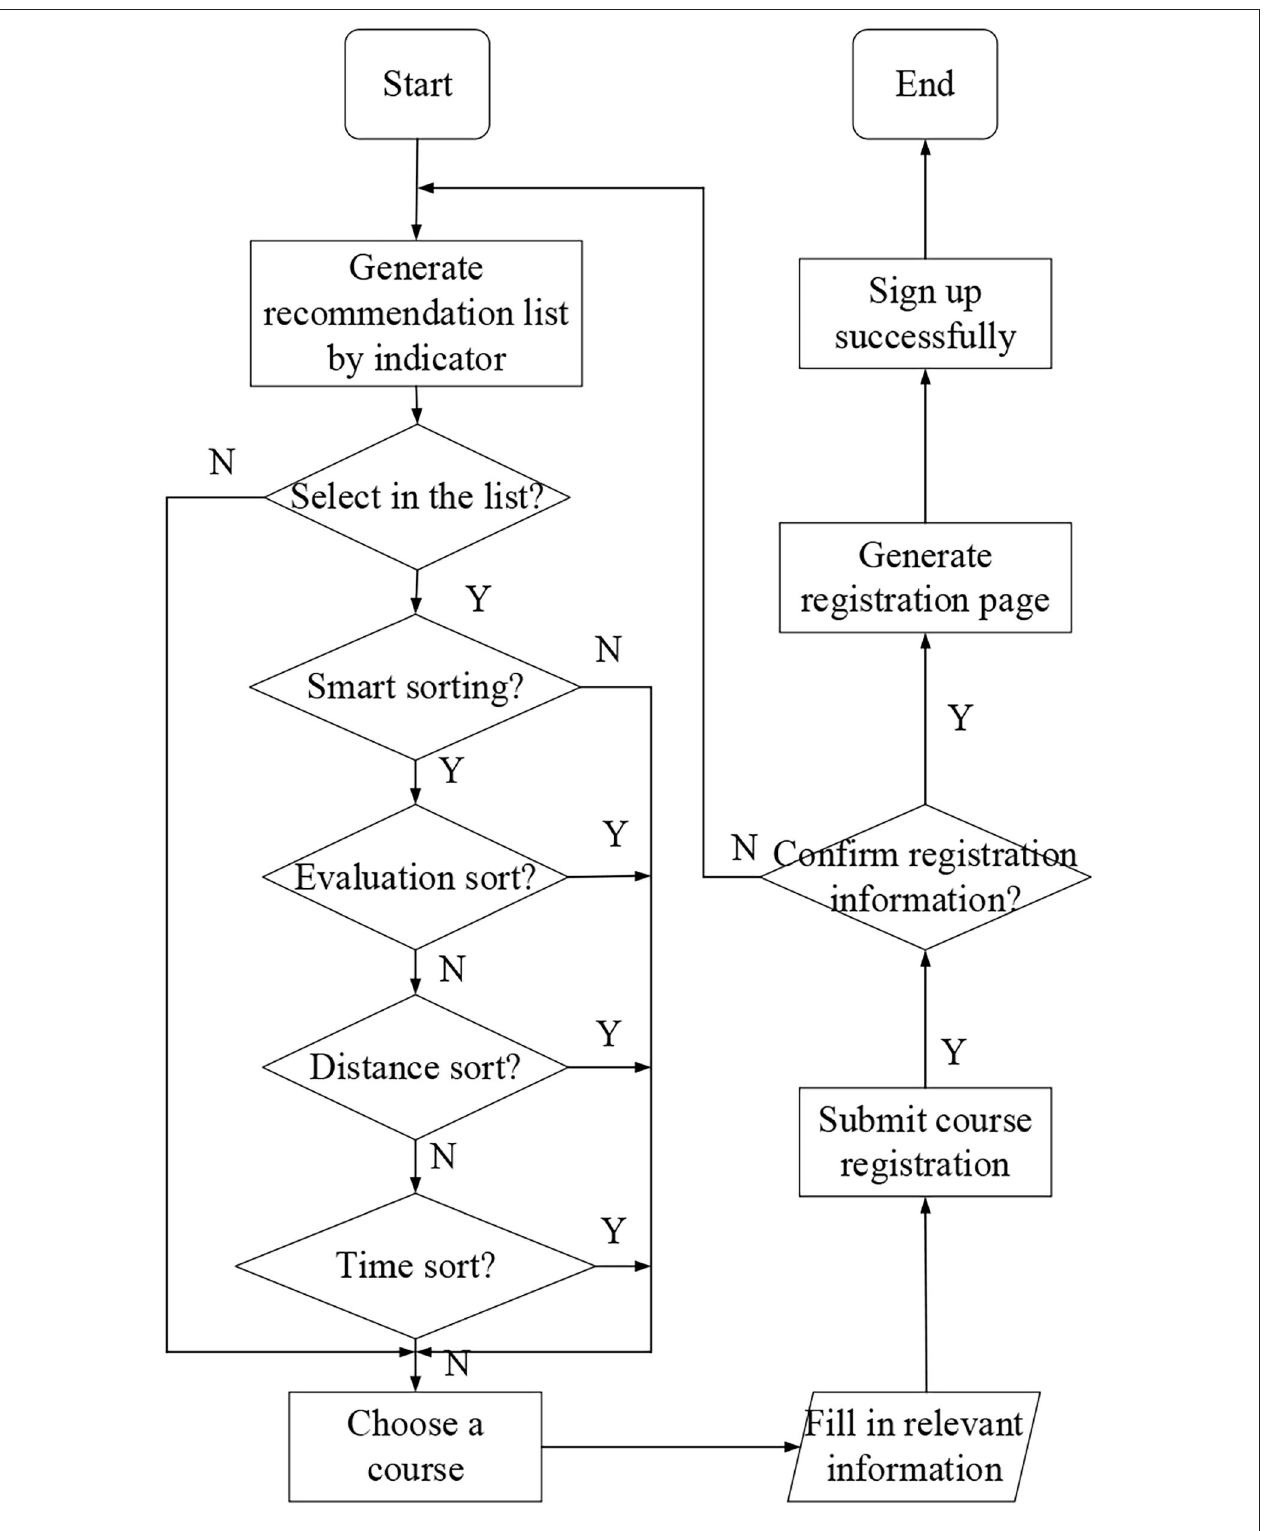
FIGURE 7 | Flow chart of course registration